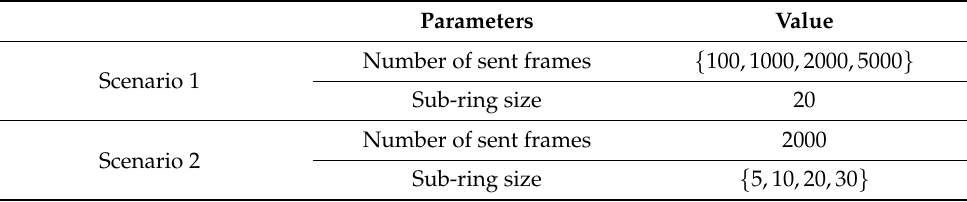
Table 2. Simulation parameters for two scenarios, where Scenario 1 is the performance result against the numbers of sent frames, and Scenario 2 is the performance result against sub-ring sizes.